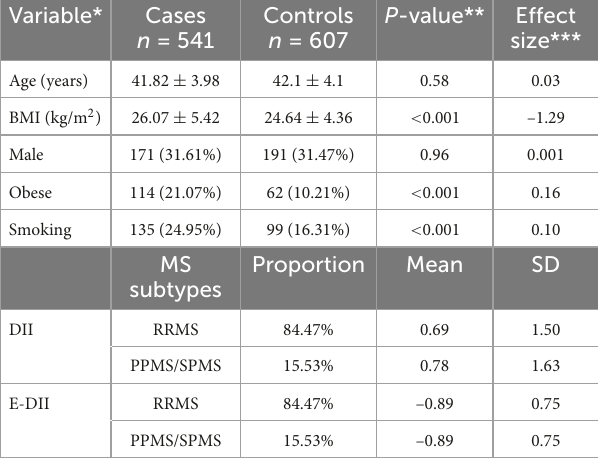
TABLE 1 Anthropometric and sociodemographic characteristics of cases with multiple sclerosis (MS) and their counterpart healthy controls, Jordan, March to June,